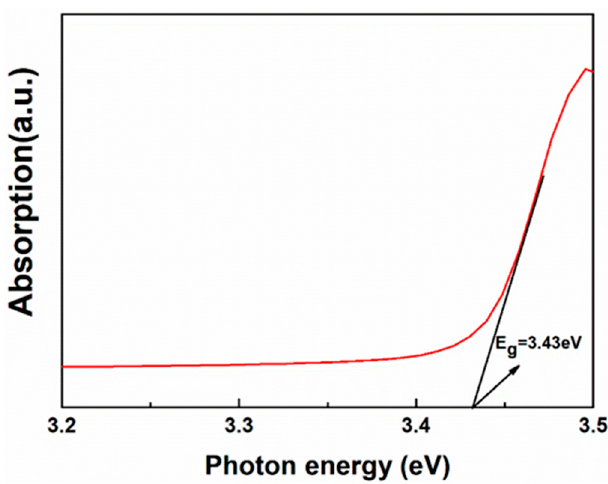
6 of 8 Table 1. Summary of the Raman results recorded from planar substrate and fitted striped PSS (patterned sapphire substrate) samples at room temperature. FWHM (full width at half maximum). Samples